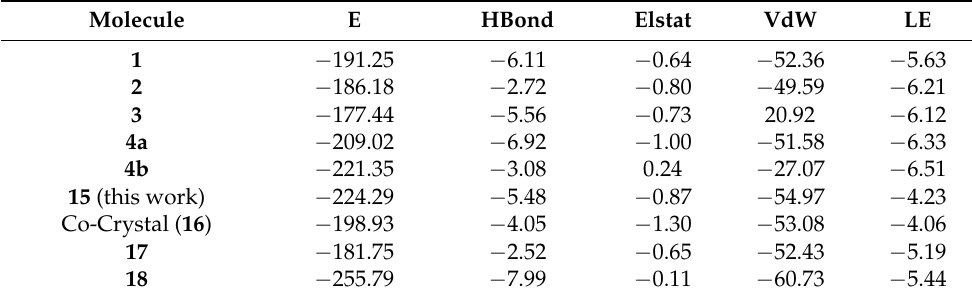
Table 1. Principal interaction energies between the studied ligands and the SARS-CoV-2-M pro . E means the total interaction energy, HBond is the hydrogen bond interactions, Elstat is the electro- static interactions, VdW represents the Van der Waals interactions, and LE is the Ligand Efficiency (LE = E/#heavy atoms), all in kcal/mol.